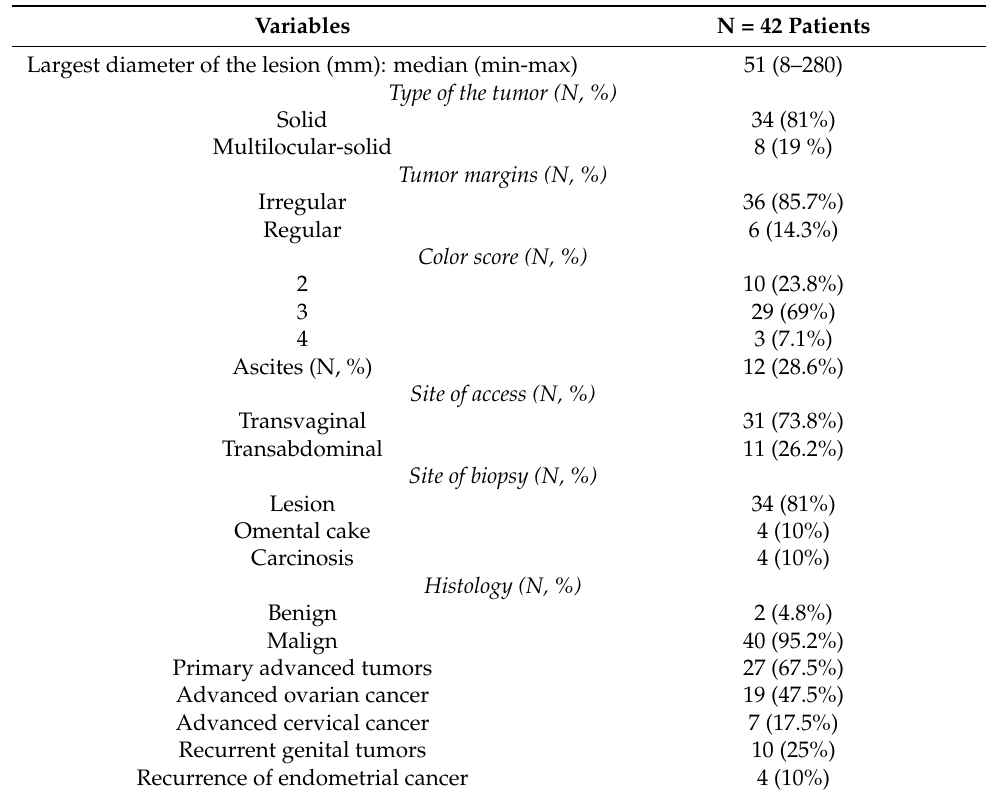
Table 2. US features and final